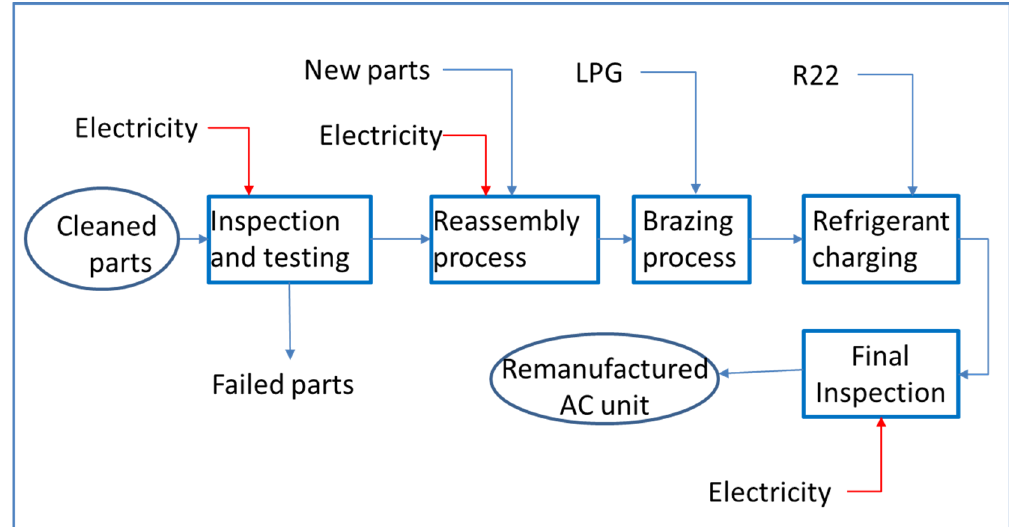
Figure 6. The processes of the reassembly phase.